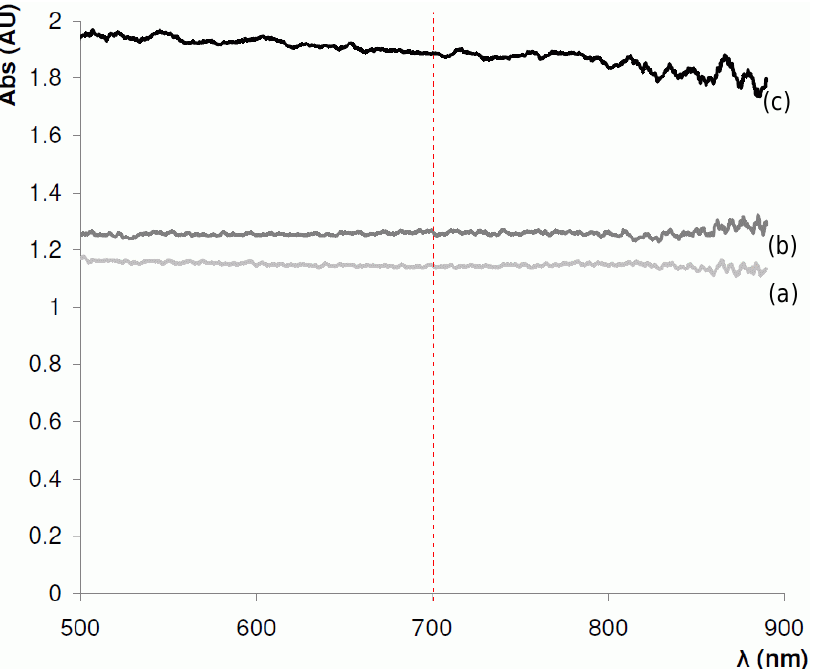
Figure 5. Absorption spectra for a 100 µm ID PTFE-coated fused silica capillary in the near-IR range (500–1000 nm) using a 100 µm optical fibre. ( a ) empty capillary; ( b ) capillary filled with butyl methacrylate–ethylene dimethacrylate (BuMA - EDMA) monomer mixture; and ( c ) capillary with a 4.2 µm BuMA -co- EDMA polymer layer.